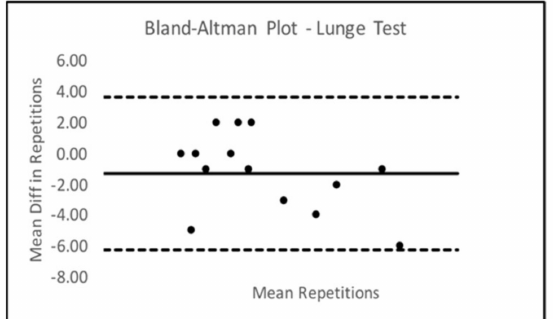
Figure 2. Bland–Altman Plot—Lunge.